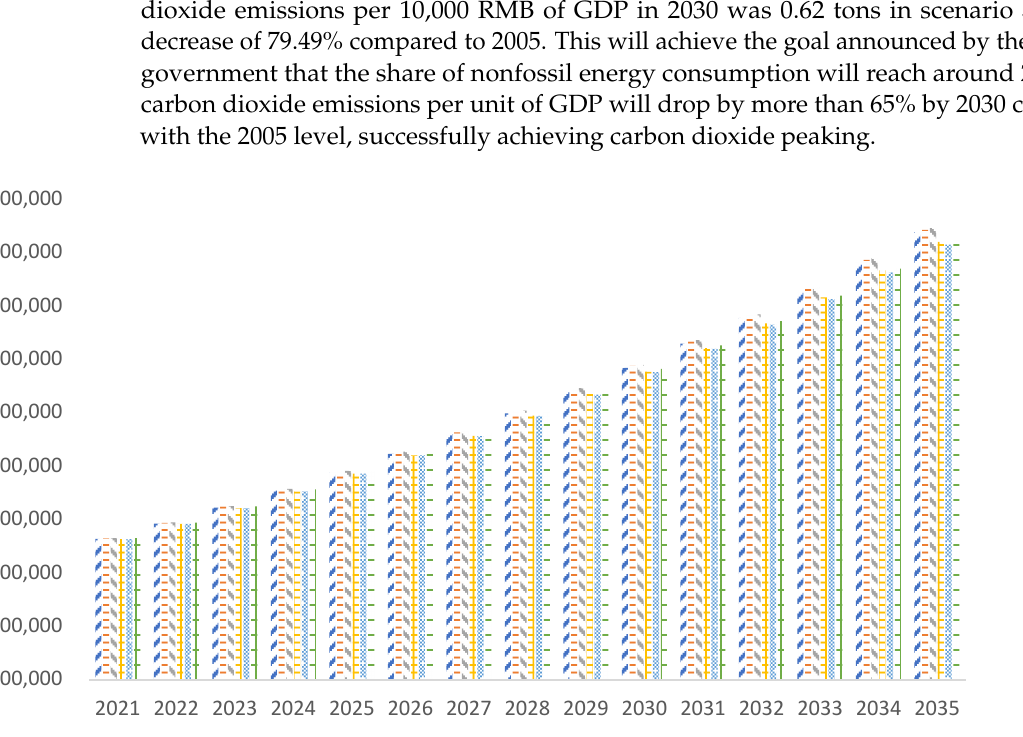
Figure 5. China’s GDP growth under different scenarios (100 million RMB).